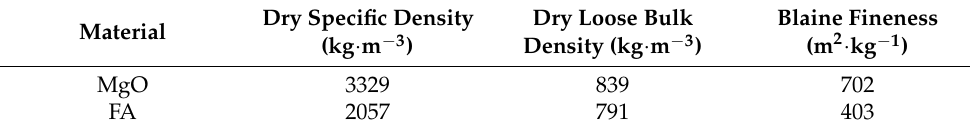
Table 3. Basic physical properties of FA and MgO.